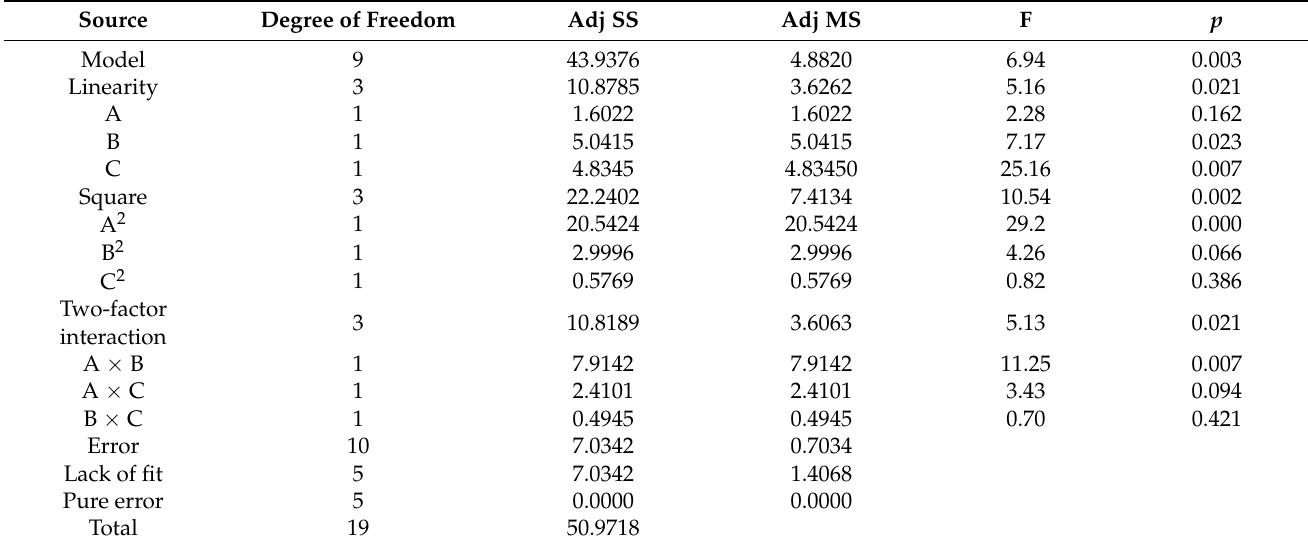
Table 9. Analysis of variance of the design efficiency of the surface response